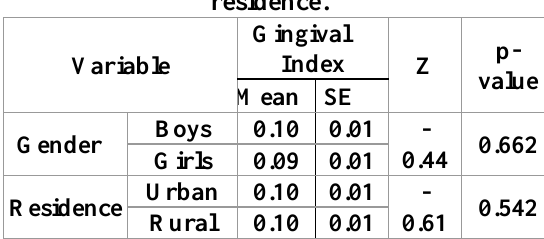
Table 6: Gingival index by gender and